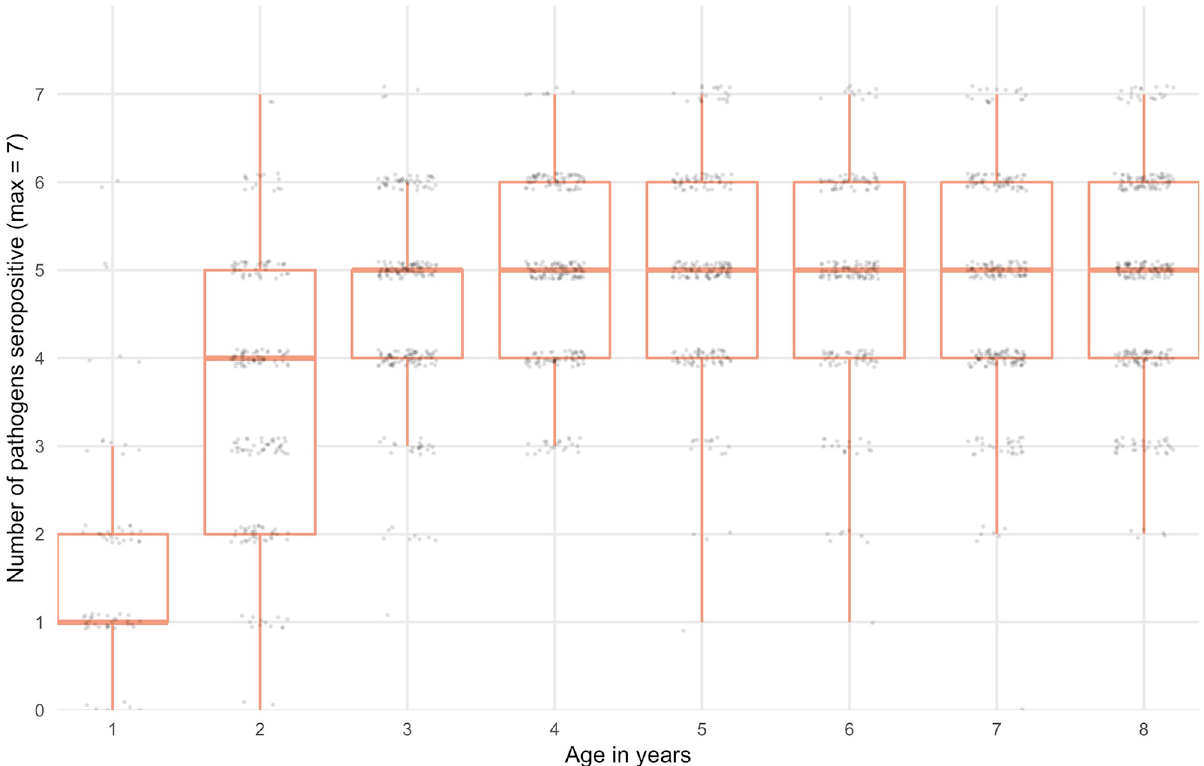
Fig 2. Seropositivity for more than 1 pathogen by age. Boxplot depicts median, upper and lower quartiles. Seropositivity cutoffs were derived using ROC curves, if available, or by fitting finite mixture models (S1 Fig). IgG response measured in multiplex using median fluorescence intensity minus background (MFI-bg) on the Luminex platform on 2267 blood samples from 2267 children.